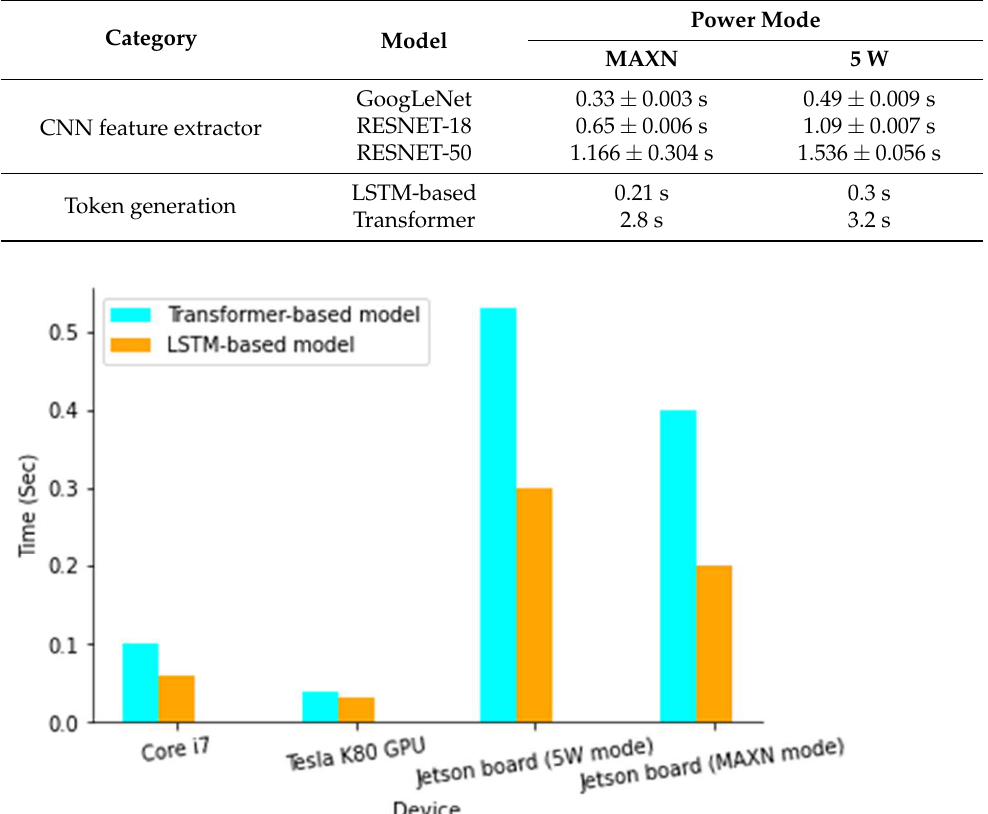
Figure 9. Model inference time comparison on different platforms.